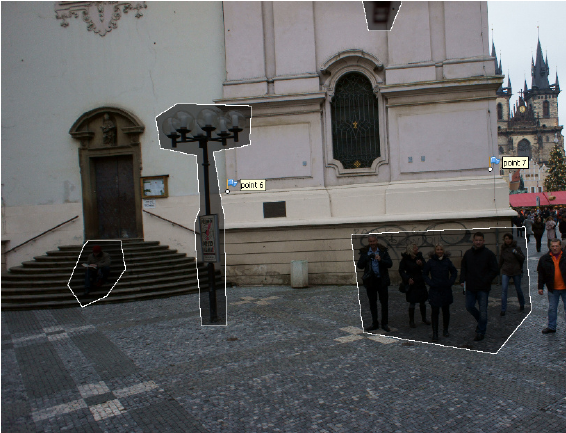
Figure 10. Masking of uninterested objects in exterior